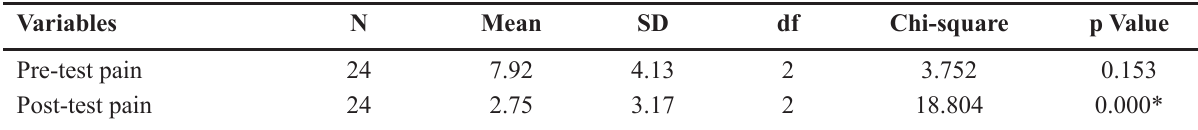
Table 2 – Kruskal Wallis summary for groups’ pain level.